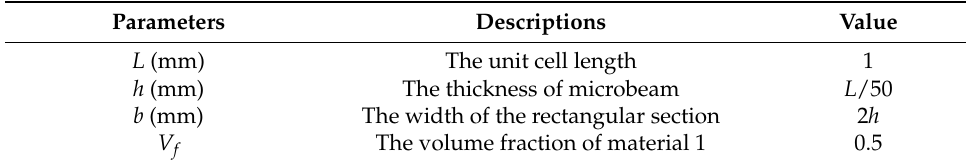
Table 1. Geometrical parameters of the micro-PnC beam.